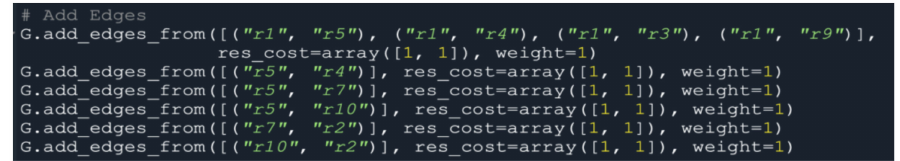
Figure 14. Static routing cost settings for paths r 1– r 5– r 7– r 2 and r 1– r 5– r 10– r